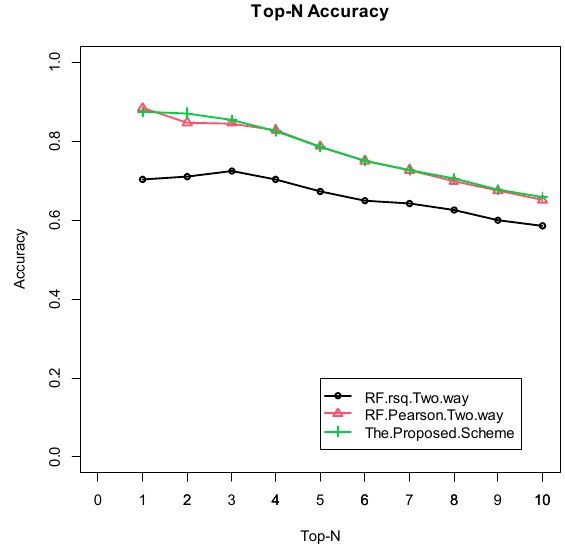
Figure 5. Top- N accuracy for the proposed CF scheme.